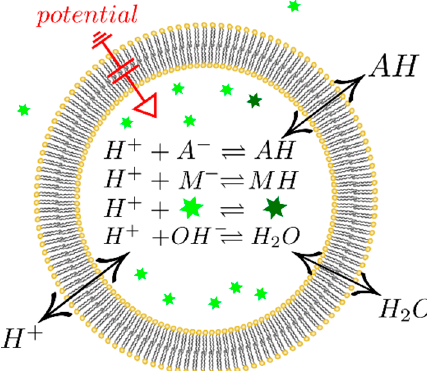
Figure 1. Graphic representation of the experimental system. Weak acid, buffer, water, and fluorophore participate in protonation/deprotonation reactions. Upon protonation, the fluorophore (bright green star) ceases to fluoresce (dark green star). Weak acid, proton, and water fluxes across the membrane are driven by the respective electrochemical gradients. Charge transfer by protons gives rise to a transmembrane potential.